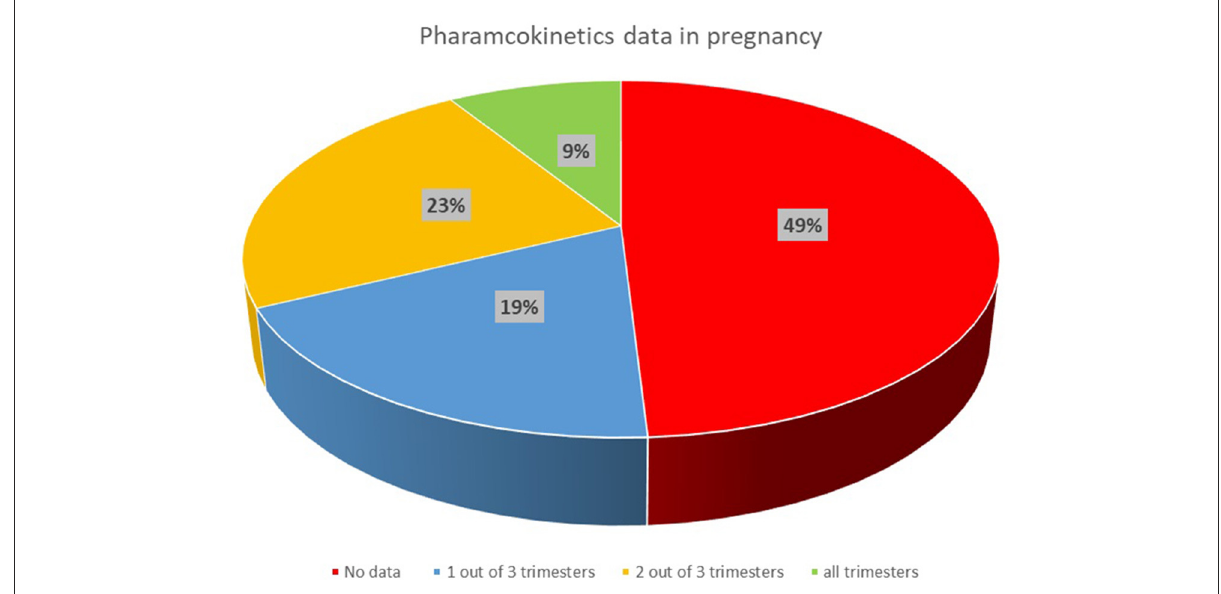
FIGURE1 Availability of published clinical PK data in pregnancy for medicines of interest in the UK.